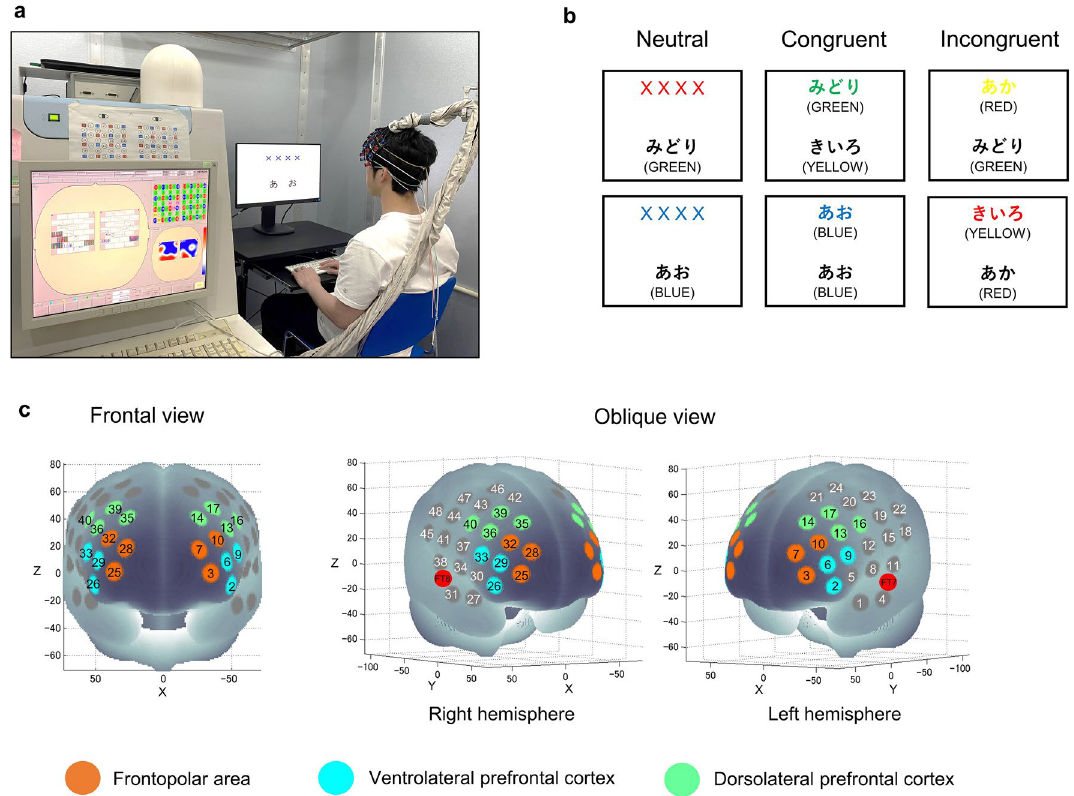
Figure 7. ( a ) Illustration of experimental setup for fNIRS measurements during the color-word matching Stroop task (CWST). ( b ) Examples of the CWST neutral, congruent and incongruent conditions. The presented words were written in Japanese. English translations are shown in parentheses. ( c ) Spatial profiles of fNIRS channels used in the present study. Two sets of probe holders were placed to cover both lateral prefrontal activation foci as in our previous studies. Colors indicate each region of interest (ROI) in the lateral part of the prefrontal ate button as fast as they could. Subsequently, reaction time (RT) and error rate (ER) were calculated. The CWST consisted of three conditions: neutral, congruent and incongruent. For the neutral condition, the upper row was presented as a row of X’s (XXXX) printed in red, green, blue or yellow, and the lower row presented the word ‘RED’, ‘GREEN’, ‘BLUE’ or ‘YELLOW’ printed in black. For the congruent condition, the upper row contained the word ‘RED’, ‘GREEN’, ‘BLUE’ or ‘YELLOW’ printed in the congruent color (e.g., ‘RED’ was printed in red), and the lower row presented the same words as in the lower row of the neutral condition. For the incongruent condition, the upper row presented the color word printed in an incongruent color to produce interference between the color word and the color name (e.g., ‘RED’ was printed in green), and the lower row presented the same words as in the lower row of the neutral and congruent conditions (Fig. 7b). Each experimental session consisted of 30 trials, made up of 10 neutral, 10 congruent and 10 incongruent trials, which appeared in random order. The upper row was presented 100 ms before the lower row in order to shift visual attention. The trial remained on the screen until the participant responded or for 2 s, whichever was shorter. Then, a fixation cross appeared on the screen as an inter-stimulus interval for 10–12 s to avoid prediction of the timing of the subse- quent trial. Stroop interference, an index of executive function in the prefrontal cortex, was calculated as the dif- ference in reaction time between the incongruent and neutral conditions 30 . All words were written in Japanese. The participants performed three practice sessions to ensure that they understood and were familiarized with the CWST well before starting the experiment. fNIRS data acquisition. Cortical hemodynamic changes were monitored using the multichannel fNIRS optical topography system ETG-7000 (Hitachi Medical Corporation, Japan) and adopting two wavelengths of near-infrared light (785 and 830 nm). The optical data from fNIRS was analyzed based on the modified Beer- Lambert Law as previously described 65,66 . With this method, we were able to calculate signals reflecting the oxygenated hemoglobin (oxy-Hb) concentration changes in a unit of millimolar-millimeter (mM∙mm) 66 . The sampling rate was set at 10 Hz. For fNIRS probe placement, two sets of 4 × 4 multichannel probe holders, which consist of 8 illuminative and 8 detective probes arranged alternately at an inter-probe distance of 3 cm resulting in 24 channels (CH) per set, were placed to cover both lateral prefrontal activation foci as in previous studies 3,4 . The left probe holder was placed such that probe 5 (between CH4 and CH11) was placed over FT7, with the